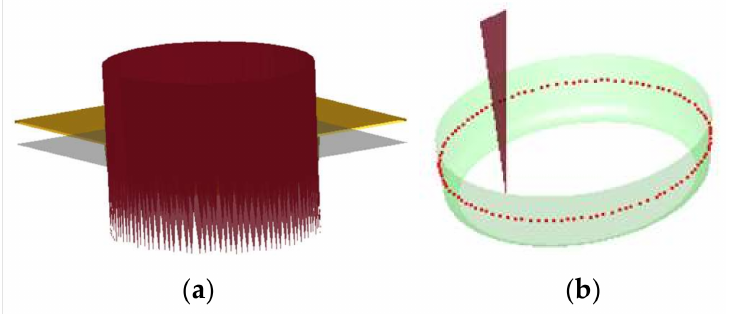
Figure 14. Vertical-plane generation: ( a ) generated vertical planes; ( b ) the single vertical plane. In the case studies, the inclination angle of the auxiliary surface α is set to 30 ◦ . The rotated plane is generated by rotating the vertical plane of 60 ◦ . The generated rotation plane is shown in Figure 15a. In order to more clearly show the rotation effect of the vertical plane, one of the rotated planes obtained by rotating the vertical plane that passes through a certain feature point is shown in Figure 15b.